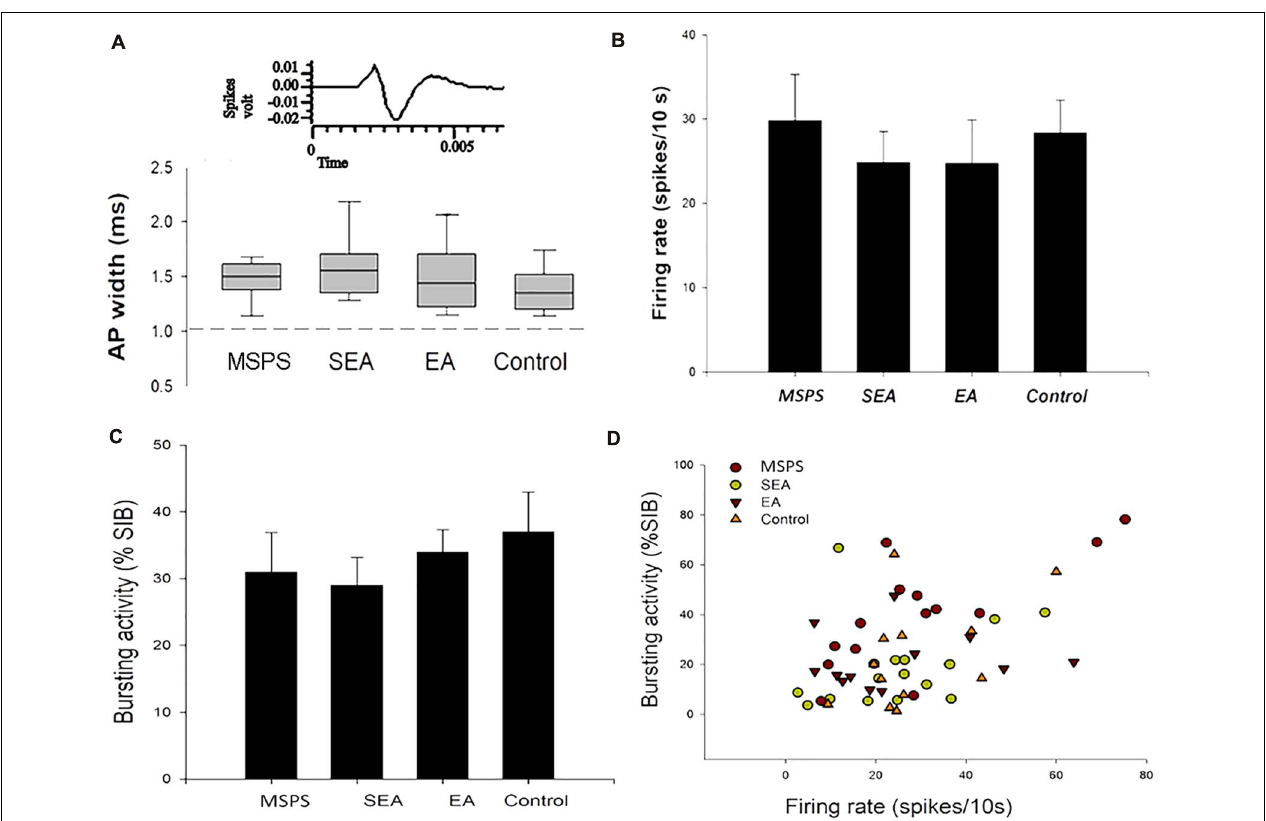
FIGURE 6 | MSPS and EA treatment alter VTA DA neuron responses. (A) Representative average extracellular neuron waveforms. The width of an action potential (AP) was measured from the start of that potential to the apex of the negative trough, and similar normal distributions of AP widths (range: 1.1–2.7 ms) were detected in PTSD rats, SEA rats, EA rats, and controls. (B–D) Average firing rates and bursting activity (%SIB) of VTA DA neurons in the indicated treatment